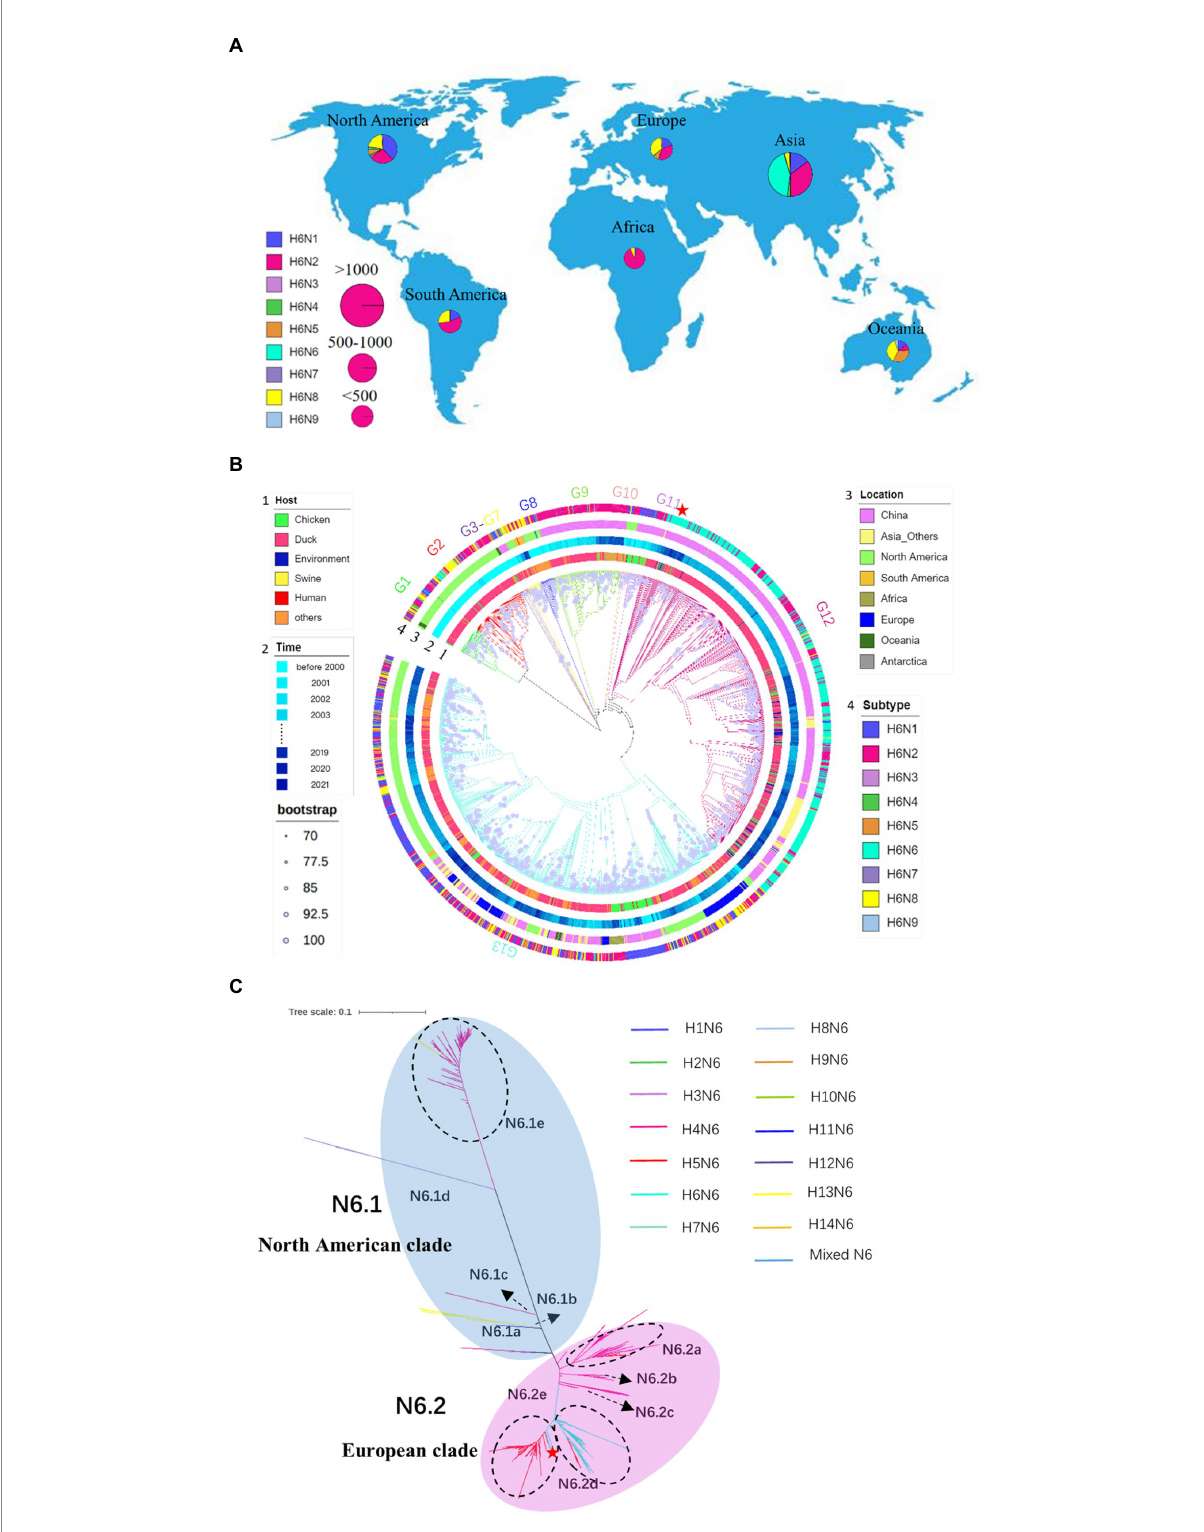
FIGURE 1 Spatial distribution of the H6-subtype influenza virus. (A) Global distribution of H6NX isolates. The proportion of isolates for each subtype category is visualized in a pie chart. The size of the pie chart is proportional to the number of isolates in each continent. (B) Phylogeny and groups of H6NX HA. Only bootstrap values ≥ 70% are visualized as a purple circle in the middle of the branch. The size of the circle is proportional to the bootstrap value. Categories of virus (such as subtype, host, location, time) are identified by different colors of circles in the outer part of the tree. Phylogenetic independent groups are indicated with different colors of branches. (C) Phylogeny and groups of HXN6 NA. Tree scale is 0.1. Different subtypes are represented by different colored branches. ZJ49 is indicated by a red five-pointed